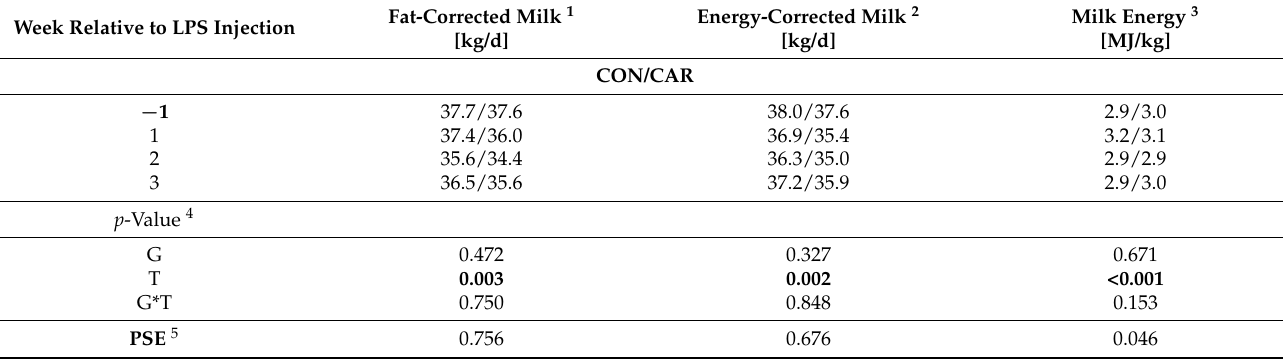
Table A4. Effects of an L -carnitine supplementation on calculated milk parameters of German Holstein cows challenged by an intravenous injection of lipopolysaccharides (LPS, 0.5 µ g/kg BW) at the first day in week 1.